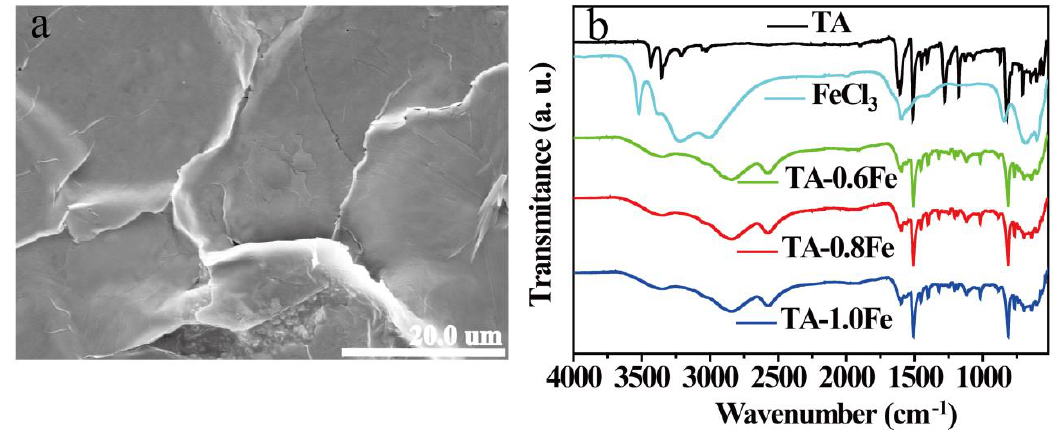
Figure 1. ( a ) SEM image of TA–0.8Fe. ( b ) FTIR spectra of TA, iron(III) chloride hexahydrate and TA–0.6Fe, TA–0.8Fe, and TA–1.0Fe. Materials 2020 , 13 , x FOR PEER REVIEW